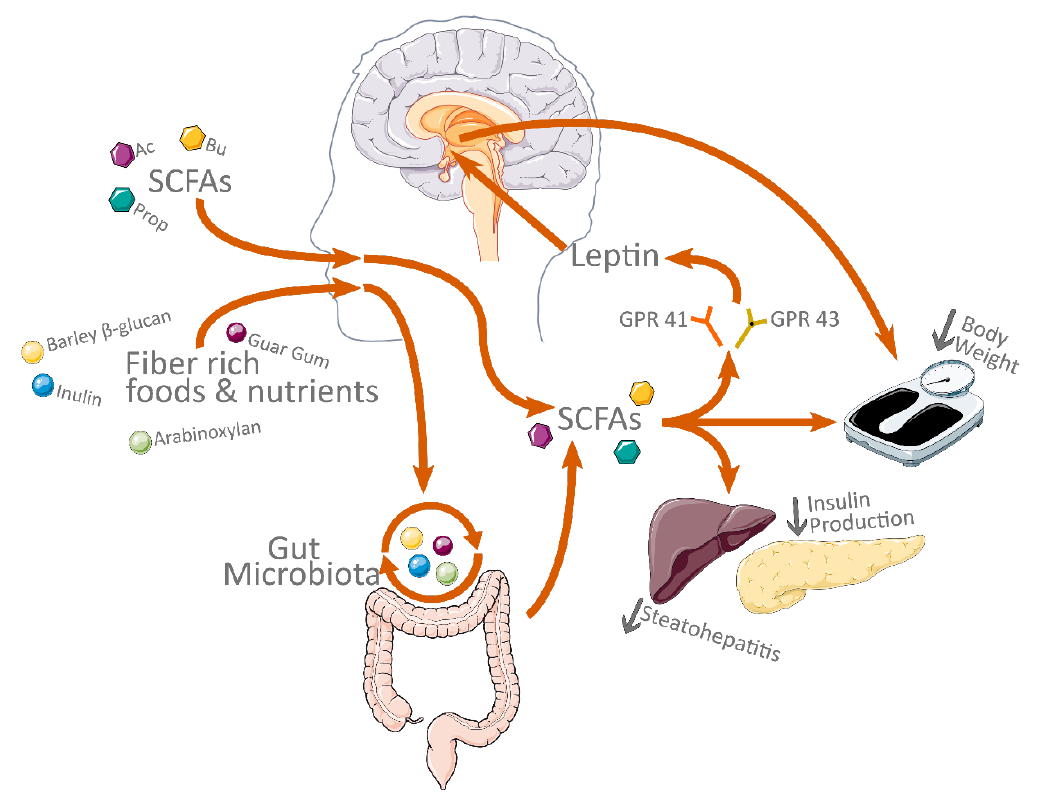
Figure 3. Overview of the effects of dietary supplements and SCFAs. Abbreviations: Ac, acetate; Prop, propionate; Bu, butyrate. The Figure was partly generated using Servier Medical Art, provided by Servier, licensed under a Creative Commons Attribution 3.0 unported license; https://smart.servier.com/ (accessed on 21 September 2022).